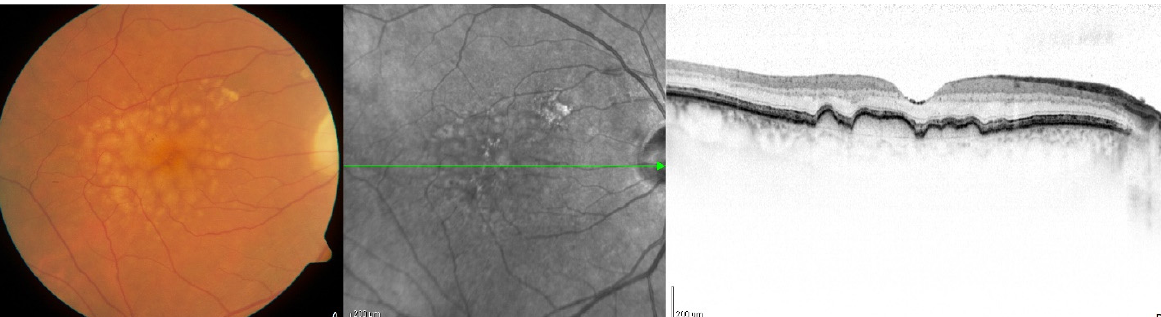
Figure 1. ( A ) Color fundus photo of macular drusen in the right eye of a 70-year-old male. ( B ) Optical coherence tomography image of macular drusen demonstrating sub-retinal pigment epithelium deposits. [Adapted with permission from Ipoliker, CC BY-SA 3.0 https://creativecommons.org/licenses/by-sa/3.0, accessed on 15 May 2022, via Wikimedia Commons]. Age is the strongest demographic risk factor for the development of AMD